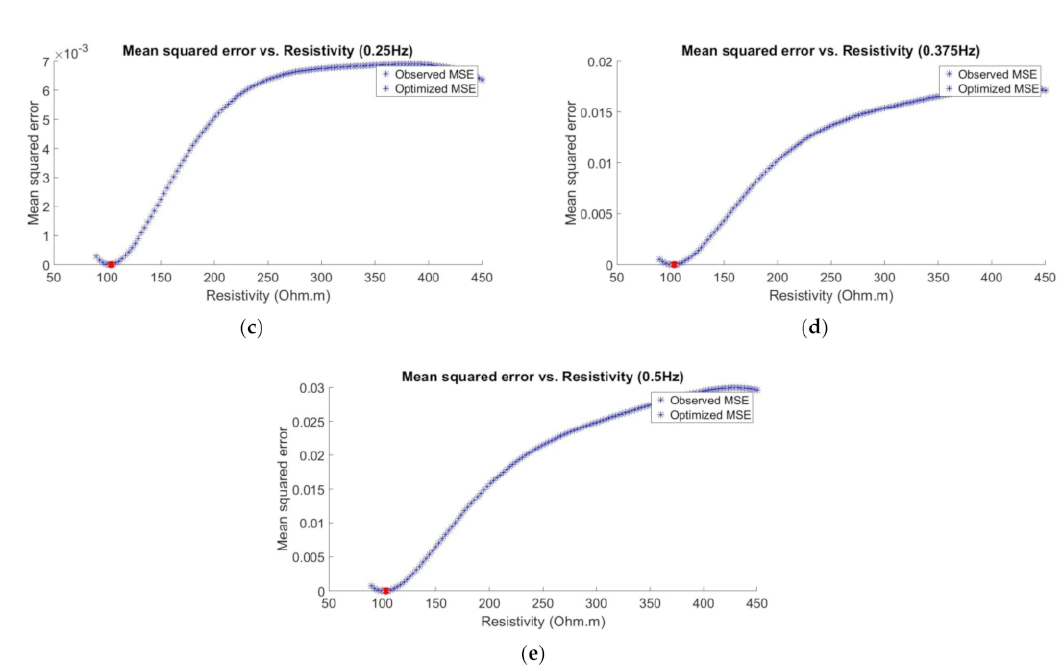
Figure 6. Mean squared error (MSE) versus hydrocarbon resistivity for multiple transmission frequencies (Observational